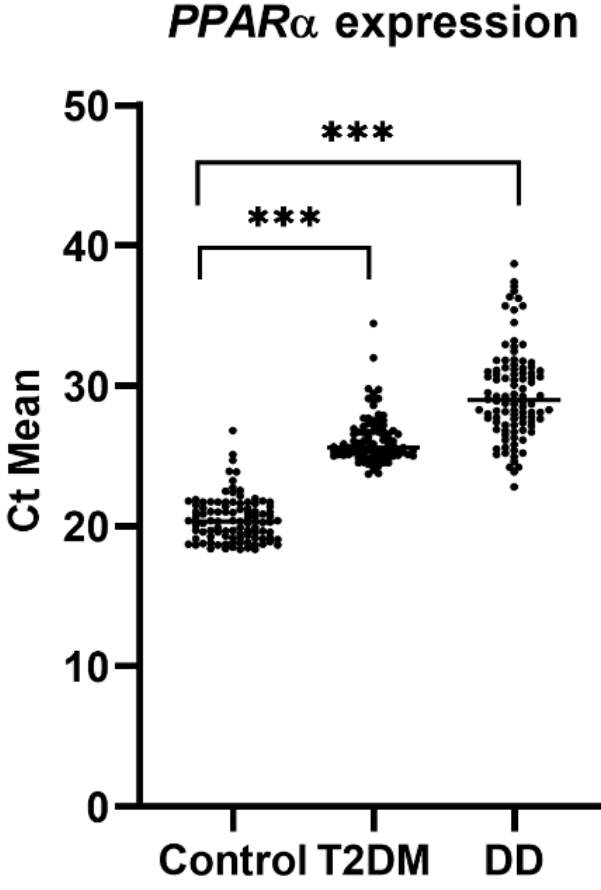
Figure 5. The mean Ct value of PPAR α expression in the control, T2DM, and DD groups. Each black dot indicates the mean Ct value of an individual sample. *** denote statistical significance ( p < 0.001). Data were collected from our previous study. (Arif M, Siddique K, Majeed A. Comparison of expression of PPAR α and SCARB1 gene in type 2 diabetic and type 2 diabetic dyslipidemia patients.